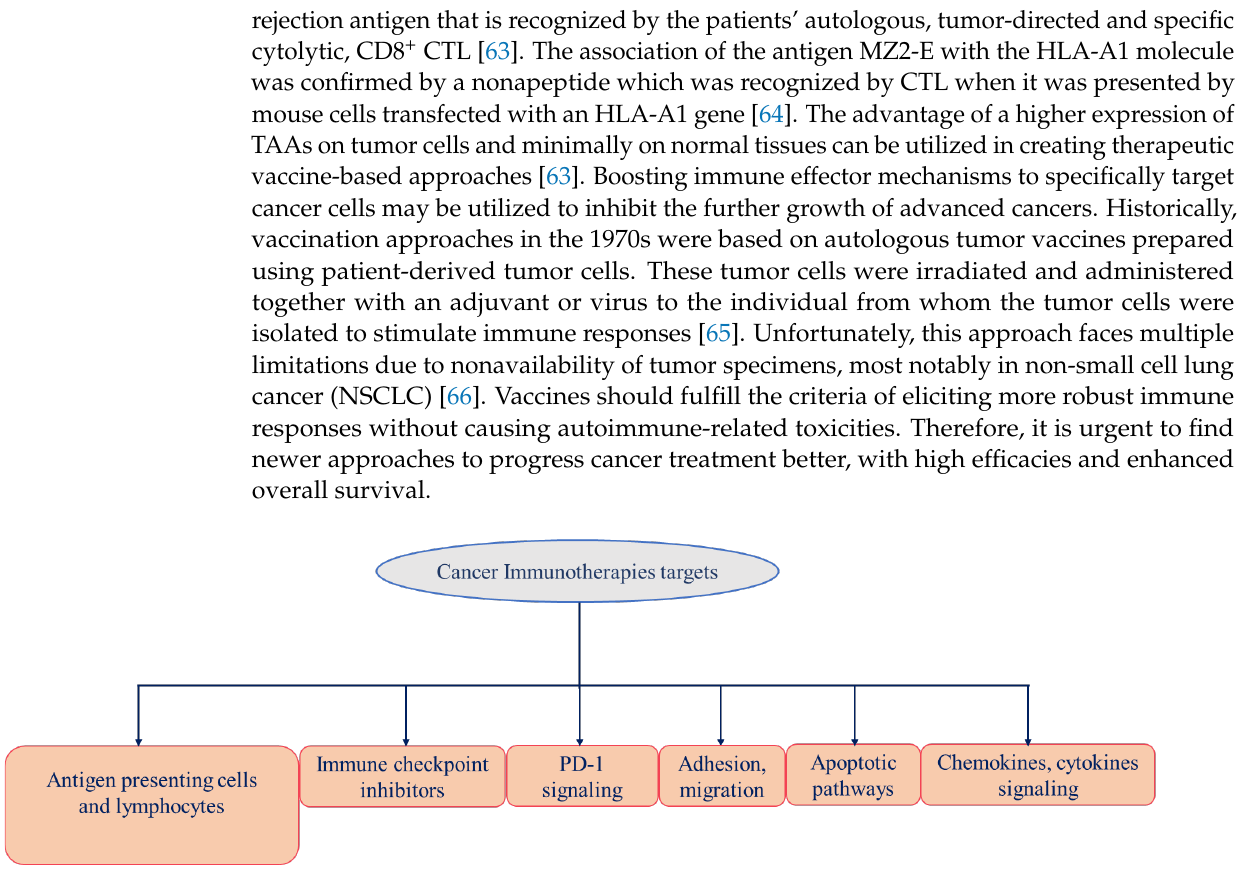
Figure 3. Promising therapies are being developed, targeting immune cells to fight cancer. Table 1. Current status of cancer clinical research on immunotherapy.